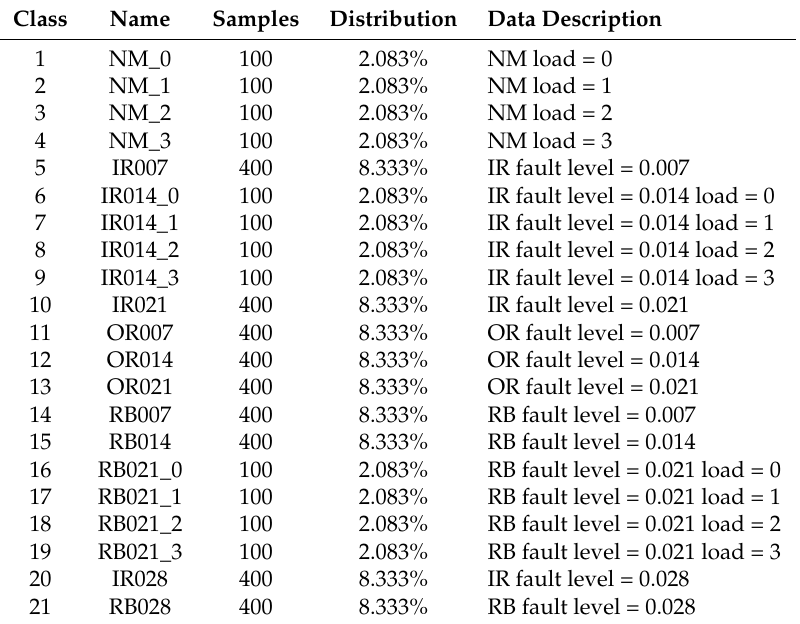
Table 2. Class distribution and description of the Case Western Reserve University (CWRU) dataset. RB, rolling